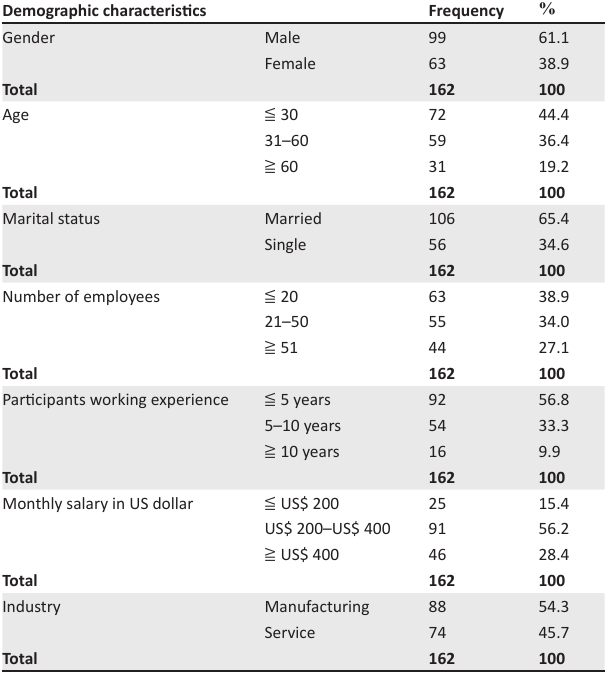
TABLE 1: Sample demographic characteristics. Demographic characteristics